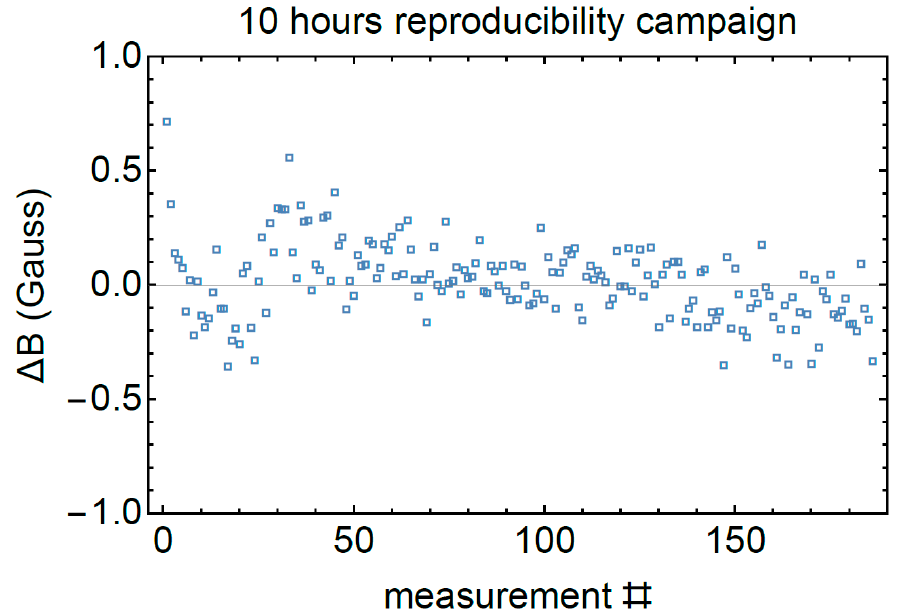
Figure 9. Repeatability performance plot showing a maximum deviation peak error of ± 0.5 G over 185 undulator traversal runs.